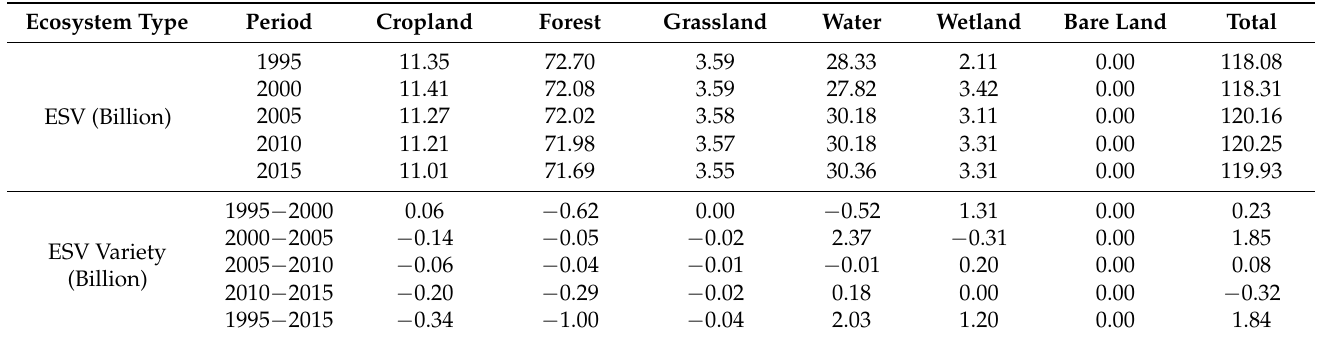
Table 4. ESVs for different land use types in Hubei Province from 1995 to 2015